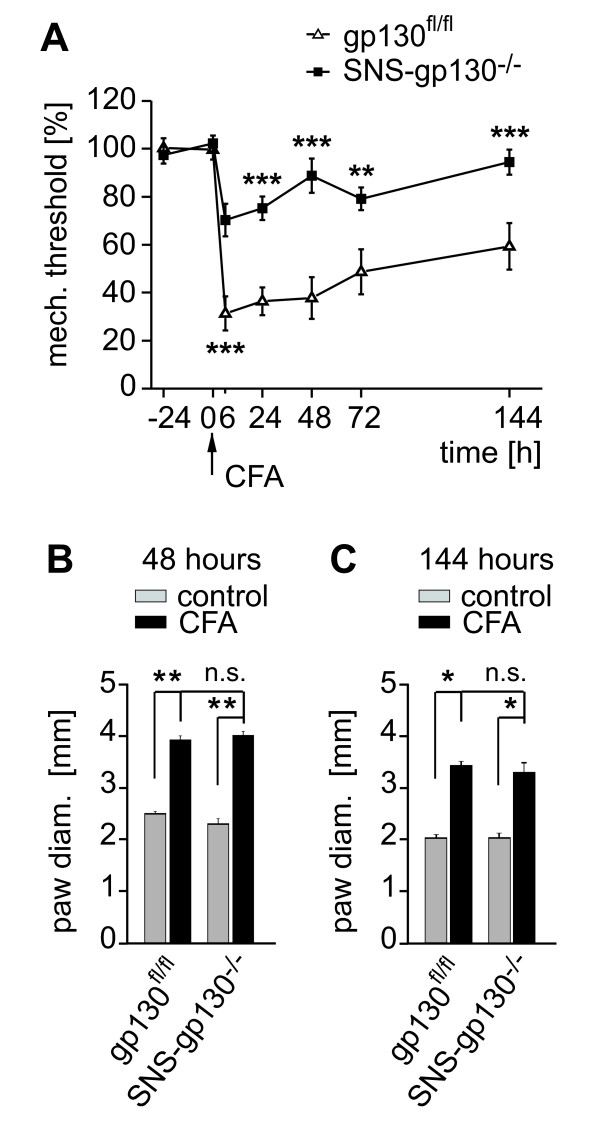
Lack of signal transducer gp130 reduced inflammation-induced mechanical hyperalgesia. (A) Unilateral hind-paw injection of CFA induced a drop of mechanical threshold after 6 h in both SNS-gp130-/- mice (black square, n = 8) and gp130fl/fl mice (open triangle, n = 8). SNS-gp130-/- mice showed attenuated mechanical hypersensitivity at all the time points tested after injection compared to gp130fl/fl mice (** p < 0.01, *** p < 0.001; ANOVA). (B, C) Similar degree of paw swelling in both mouse strains at 48 and 144 h after CFA injection (* p < 0.05, ** p < 0.01; Mann-Whitney U-test).